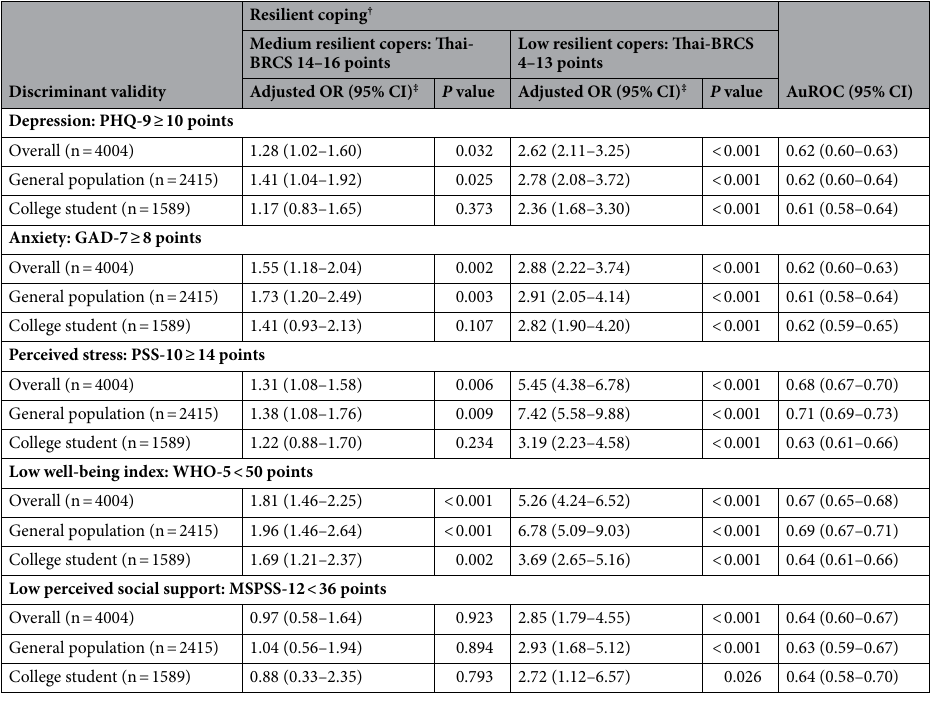
Table 4. Discriminant validity of the Thai-BRCS version questionnaire. † Reference group: high resilient copers (Thai-BRCS 17–20 points). ‡ Adjusted for age, sexual identity, marital status, religion, living status, household family member, history of mental illness, quarantine status, and willingness to quarantine. AuROC area under the receiver operating characteristic, BRCS Brief Resilient Coping Scale—4-items, CI confidence interval, GAD-7 Generalized Anxiety Disorder—7-items, MSPSS-12 Multidimensional Scale of Perceived Social Support—12-items, PHQ-9 Patient Health Questionnaire—9-items, PSS-10 Perceived Stress Scale—10- items, WHO-5 World Health Organization Five Well-Being